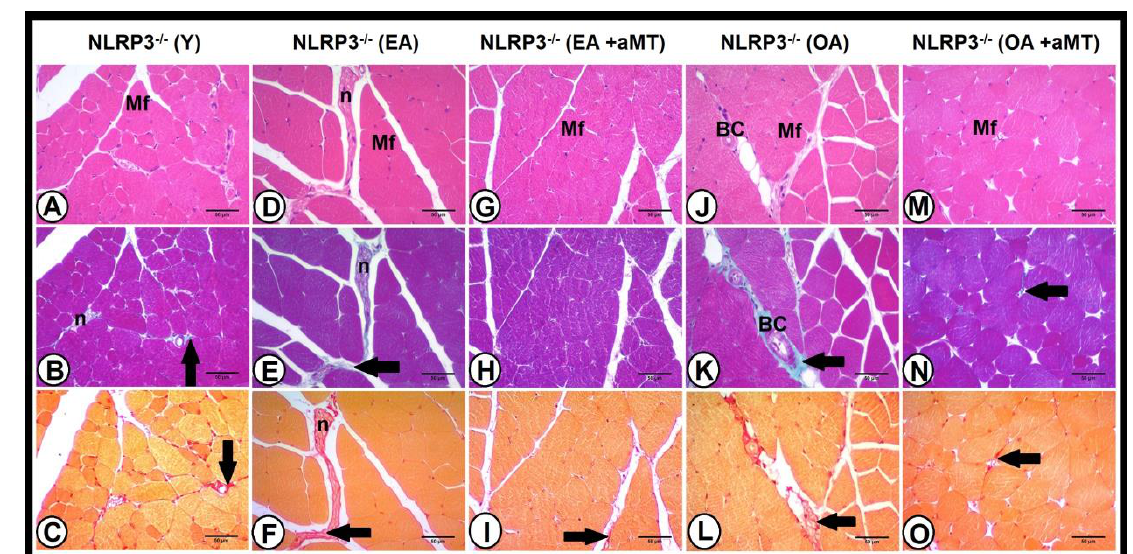
Figure 7. Impact of NLRP3 inflammasome and melatonin supplementation on the gastrocnemius muscle structure during aging. Photomicrographs of cross section of the gastrocnemius muscles of the young (Y), early aged (EA), early aged with melatonin (EA + aMT), old-aged (OA), and old-aged with melatonin (OA + aMT) NLRP3 − mice stained with H&E ( A , D,G , J , M ); Crossmon’s trichrome ( B , E , H , K , N ), and Van Gieson ( C , F , I , L , O ) stains. ( A – C ) Photomicrographs of the Y mice showing better skeletal muscle fibers (Mf) arrangement, with less percentage of collagenous fibers (arrows). ( D – F ) Photomicrographs of the EA animals revealing increase of the interstitial spaces, with significant induction of collagenous tissue accumulation (arrows) in interstitial spaces around nerve fibers (n). ( G – I ) Photomicrographs of the EA animals after melatonin therapy exhibiting the conservative effect of melatonin against age-associated muscular changes, where melatonin restored muscle fibers (Mf) architecture and reduced collagen (arrows) in interstitial spaces. ( J – L ) Photomicrographs of the OA mice illustrating increased collagen accumulation (arrows) in interstitial spaces around blood capillaries (BC). ( M – O ) Photomicrographs of OA mice after melatonin administration depicting the protective effect of melatonin on preserving muscle fibers (Mf) structure and inhibiting collagen deposition (arrows). Bar = 50 µ